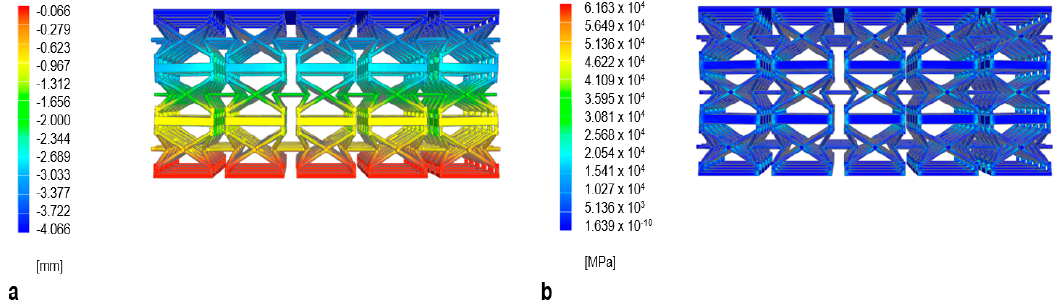
Figure 10. Overall deformation ( a ) and von Mises stress distribution ( b ) of the meta-functional auxetic composite bridge bearing model under compression at vertical displacement of 4 mm.